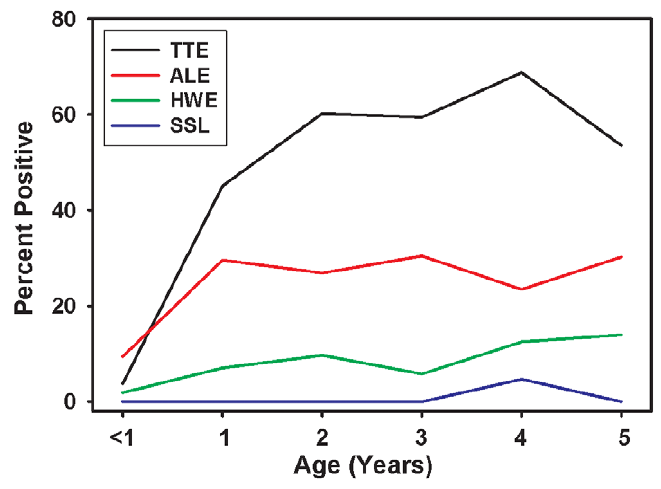
Figure 1. Prevalence of intestinal helminths. The prevalence of Trichuris trichiura eggs (TTE), Ascaris lumbricoides eggs (ALE), Hookworm eggs (HWE) and Strongyloides stercoralis larvae (SSL) was assessed in stools from children enrolled in the longitudinal cohort during the first 5 years of life.